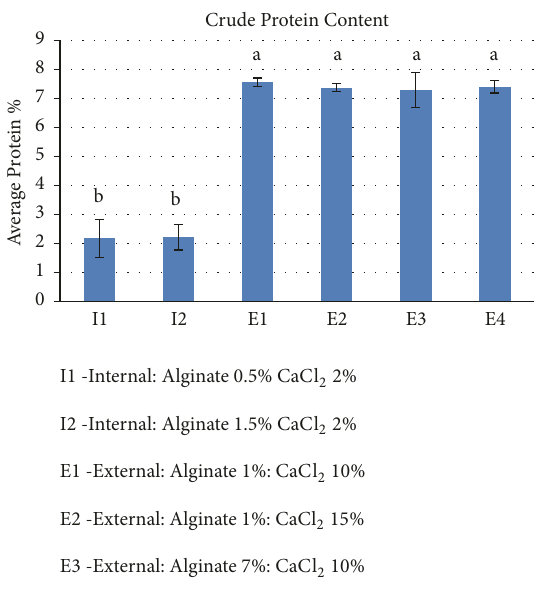
Figure 4: Crude protein content of spirulina-alginate beads for different formulations. Error bars represent ± S.D (n= 3). The bars with different letters are significantly different ( 𝛼